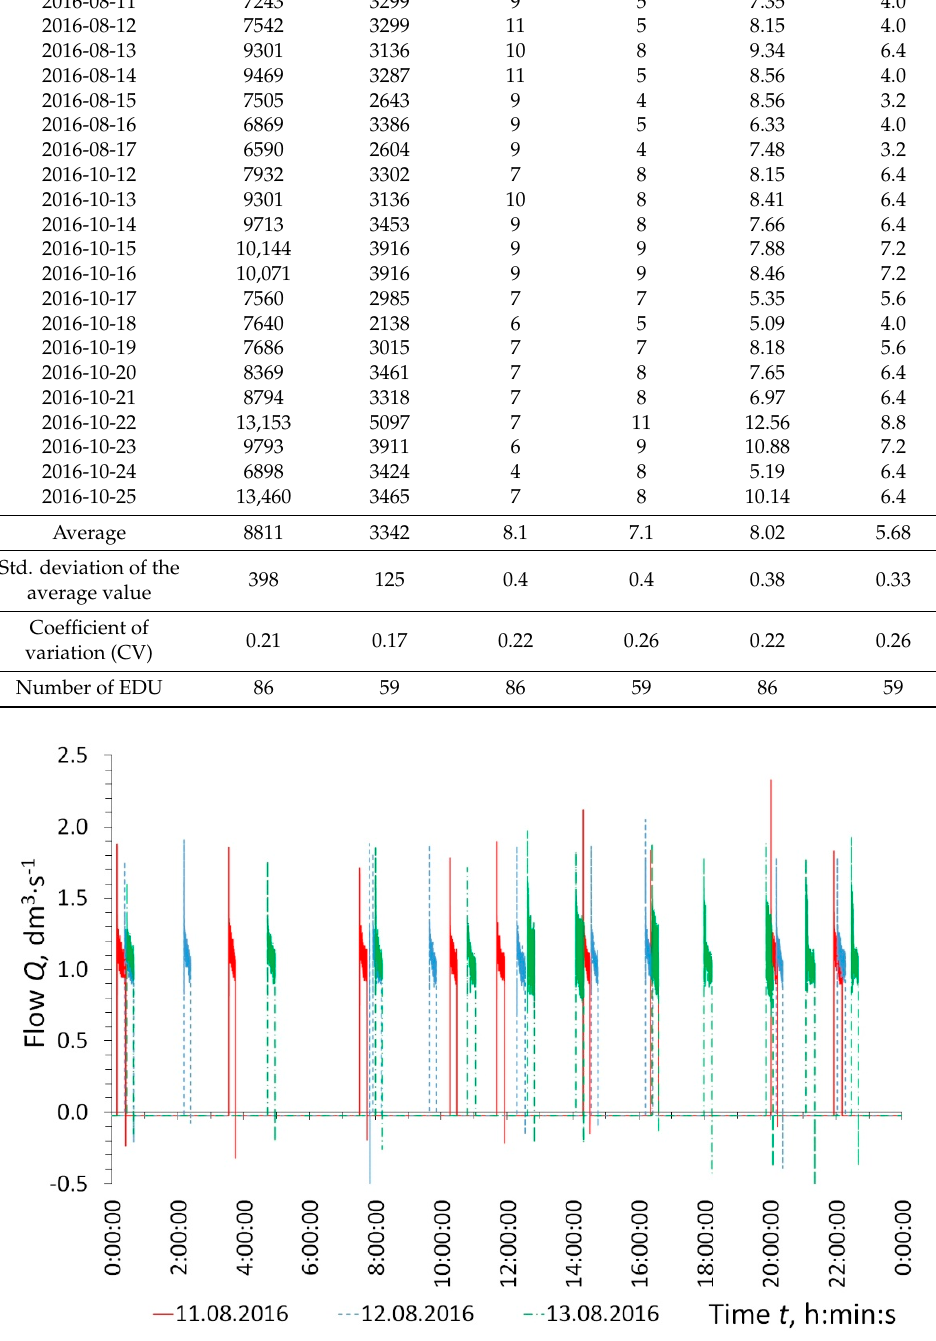
Figure 10. Flows measured 11–13 August 2016 at PS_1.